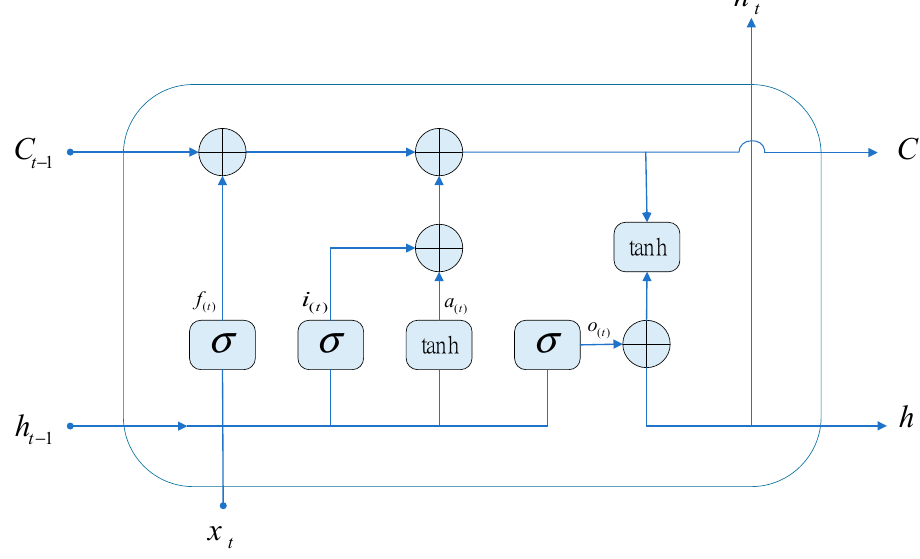
Figure 6. Graphical illustration of the LSTM.